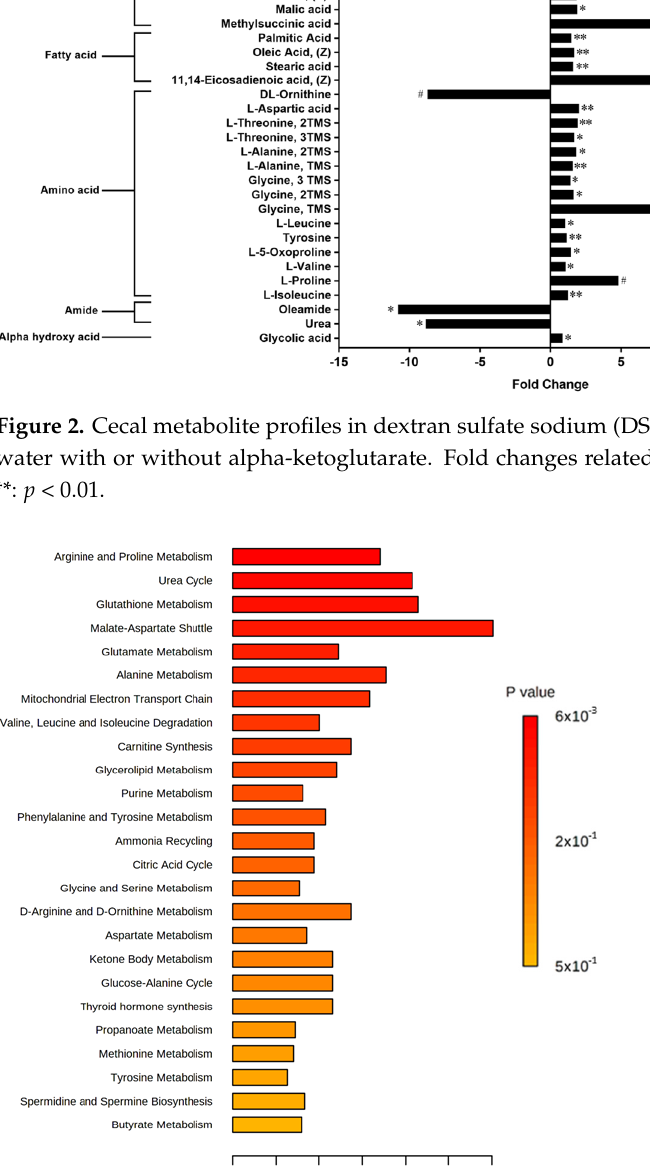
Figure 3. Pathway enrichment analysis of the differential metabolites in cecal samples of dextran sulfate sodium (DSS)-induced colitis mice receiving water with or without alpha-ketoglutarate.